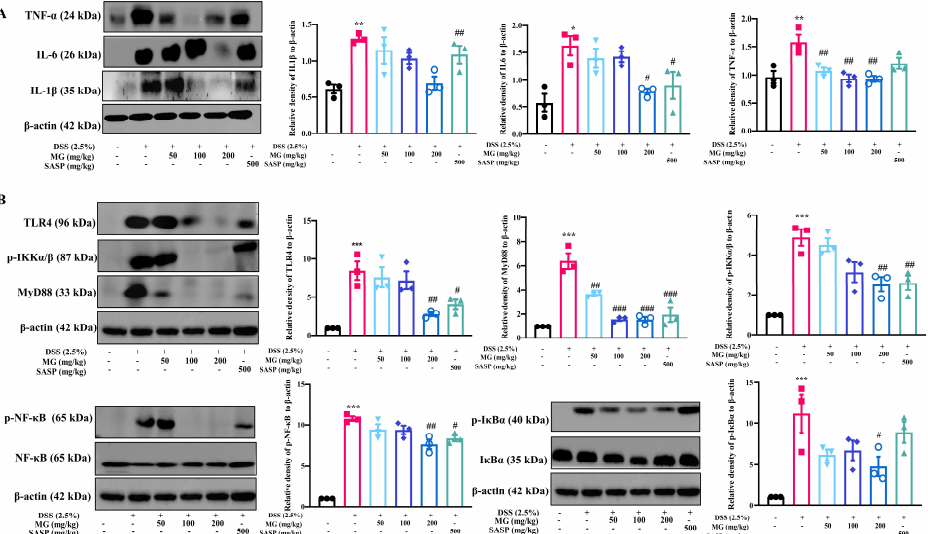
Figure 5. MG inhibites the expression of inflammatory cytokines ( A ) and TLR4/NF−κB signaling pathway activation ( B ) in vivo. Data were presented as the means ± SEMs of three independent experiments. * p < 0.05, ** p < 0.01, and *** p < 0.001 vs. the normal group; # p < 0.05, ## p < 0.01, and ### p < 0.001 vs. the DSS group.